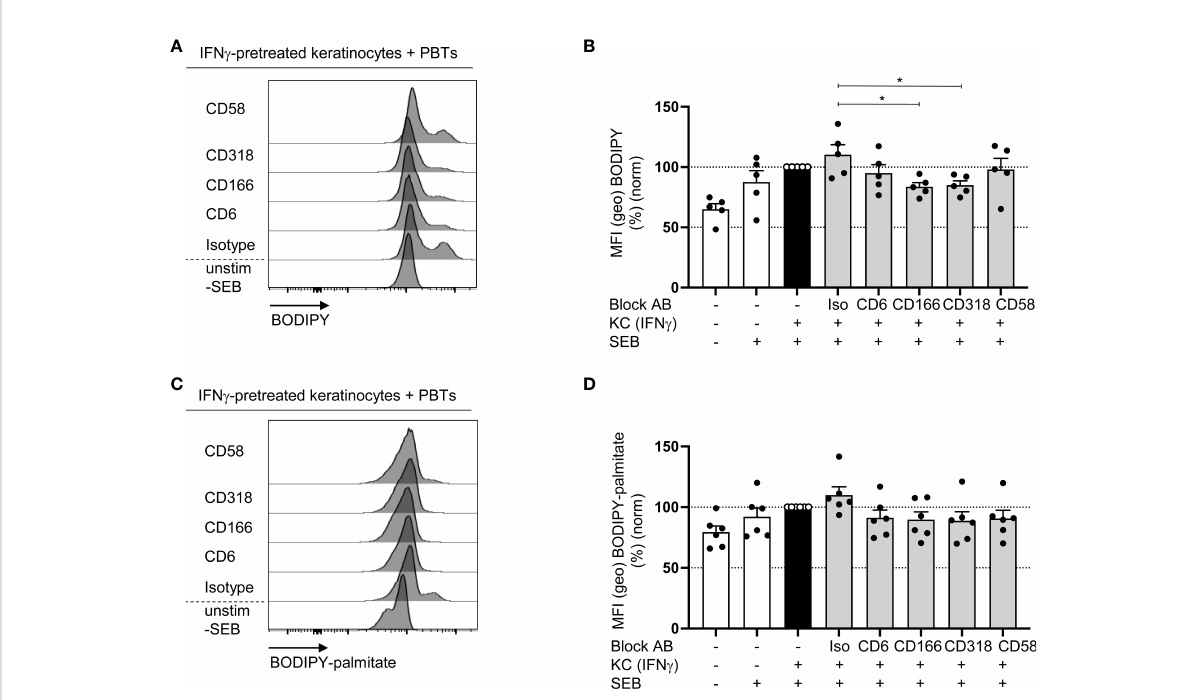
FIGURE 8 Blockade of the interaction between CD6, CD166 or CD318 impairs fatty acid synthesis (A, B) but not fatty acid uptake (C, D) . CD3 + PBTs were cultured for 72 h with untreated KCs (white bars) or IFN g -pretreated KCs (black and grey bars), loaded with SEB and the effects of blocking antibodies against CD6, CD166, CD318 or CD58 or isotype control antibodies (iso) were analyzed. (A, B) Representative histograms (A) and statistical evaluation (B) of BODIPY staining in PBTs analyzed by fl ow cytometry (n = 5 individual T cell donors). (C, D) Representative histograms (C) and statistical evaluation (D) of BODIPY-palmitate staining in PBTs analyzed by fl ow cytometry (n = 6 individual T cell donors). Data was normalized to PBTs cultured with IFN g -pretreated KCs loaded with SEB (black bar). Data is represented as mean ± SEM.